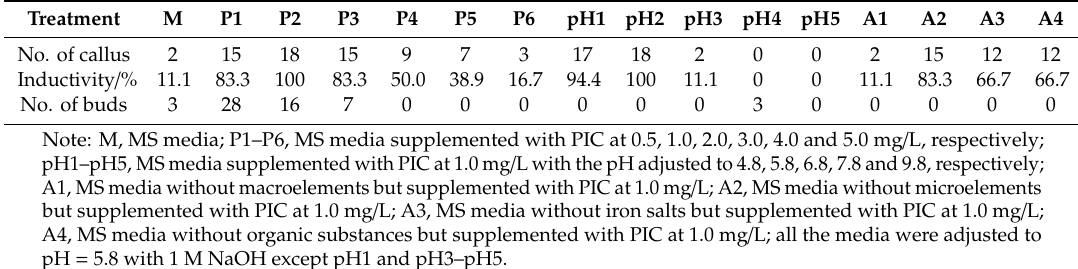
Table 2. The results of callus induction in di ff erent media.